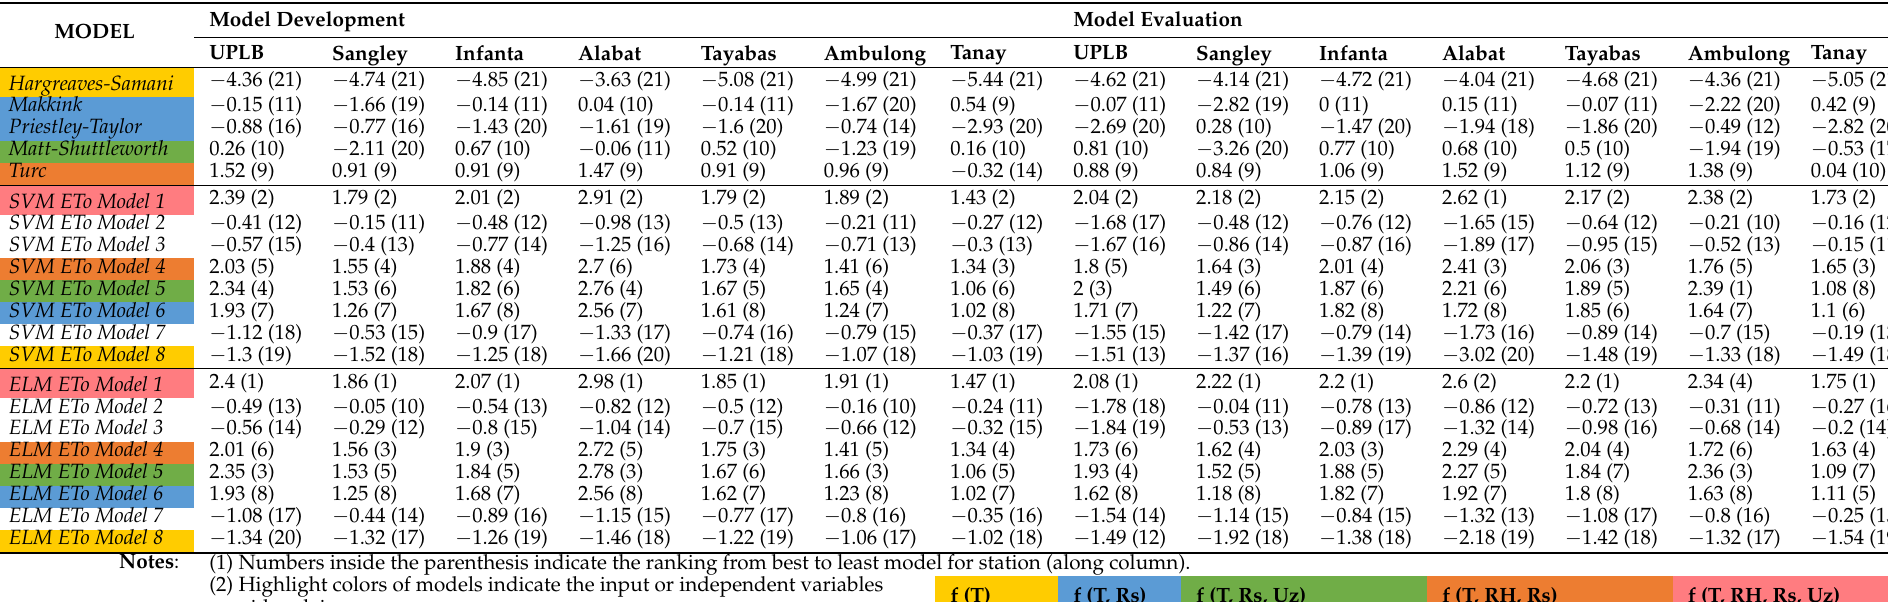
Table 12. Computed GPI (and ranking) for different empirical and machine learning models used for the estimation of daily